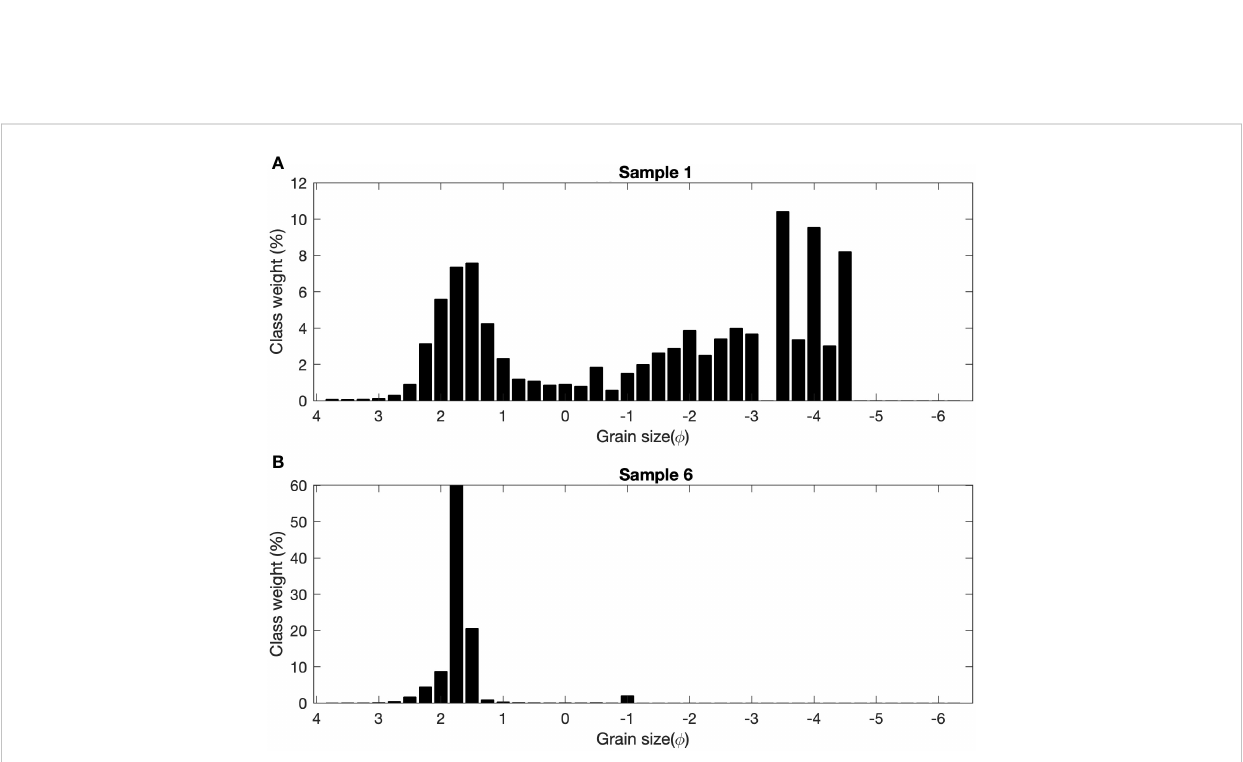
FIGURE 5 Typical sediment grain size distributions shown for two contrasting sites. (A) Sample 1 is Sandy Gravel, Polymodal, Very Poorly Sorted, Fine Skewed, Very Platykurtic, and D50 = -2.127 f . (B) Sample 6 is Slightly Gravelly Sand, Unimodal, Very Well Sorted, Symmetrical, very Leptokurtic, and D50 = 1.598 f